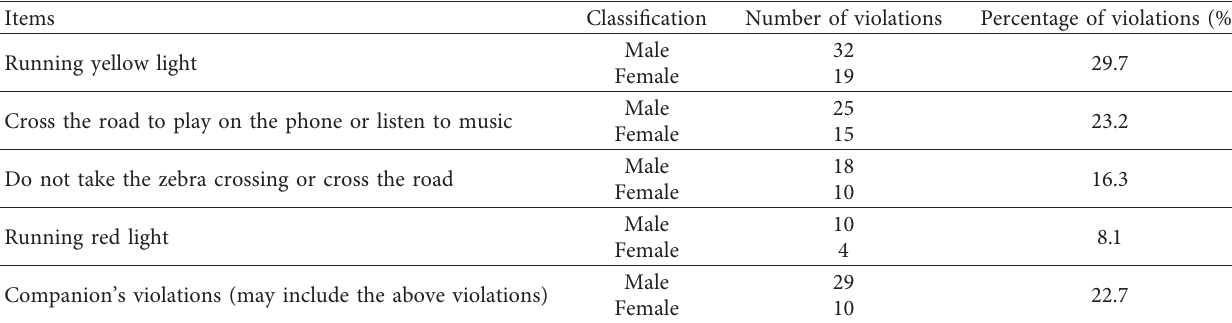
Table 3: Illegal behaviors of young pedestrians observed at